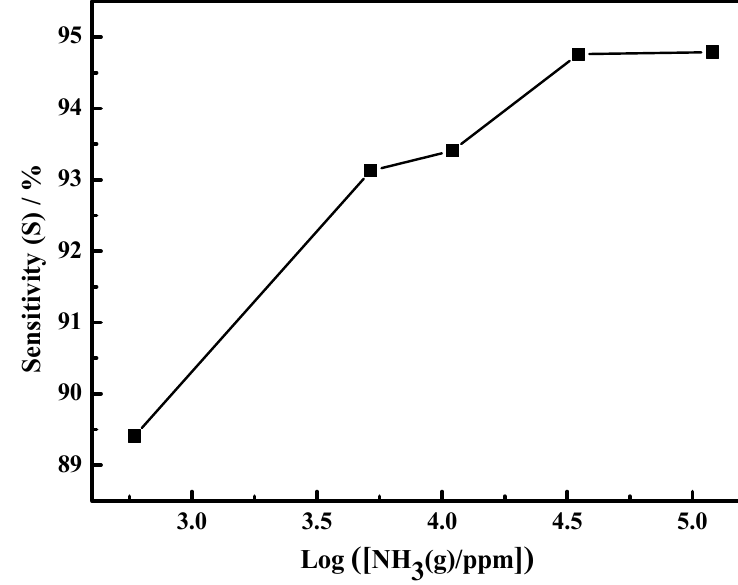
Figure 12. Sensitivity of the ZnO thick film as a function of ammonia concentration at room temperature (23